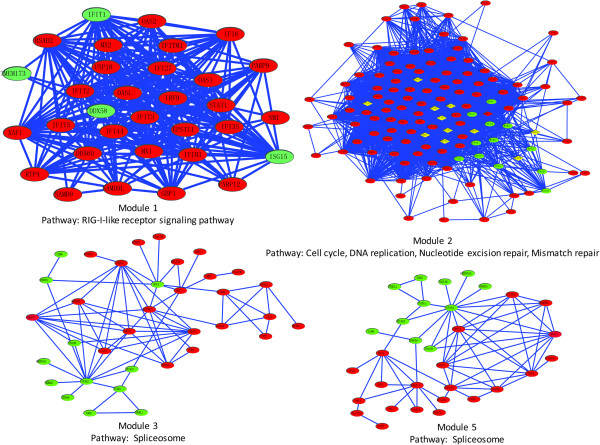
The enriched KEGG pathways of five fronting modules in the network. Red represents nodes that did not participate in signal pathways in the network, while other colors imply the nodes which participated in the signal pathways. Module 2 participated in four KEGG pathways: cell cycle, nucleotide excision repair and mismatch repair, and DNA replication. In addition, yellow represents genes participating in the cell cycle pathway, while green represents genes participating in DNA replication, nucleotide excision and mismatch repair pathway as these pathways shared some common genes (RFC5, RFC3, RFC4, POLE2, PCNA, and RPA3).